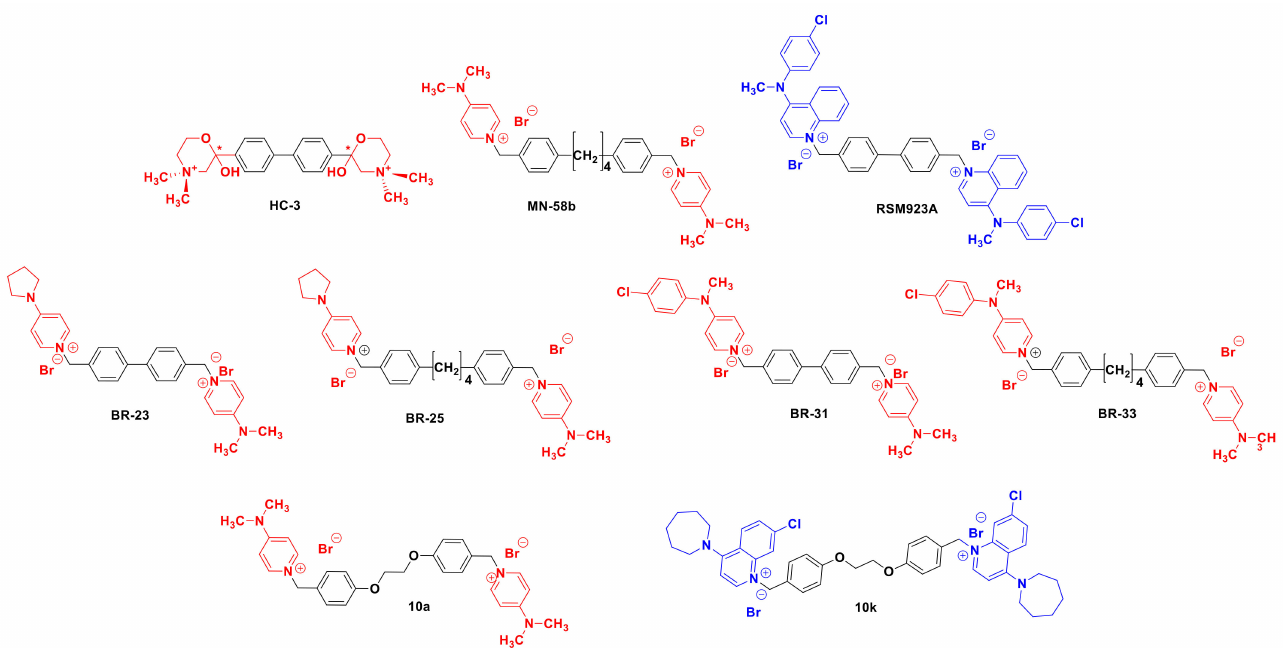
Figure 1. Reference compounds. In red color pyridinium derivatives and in blue color quinolinium